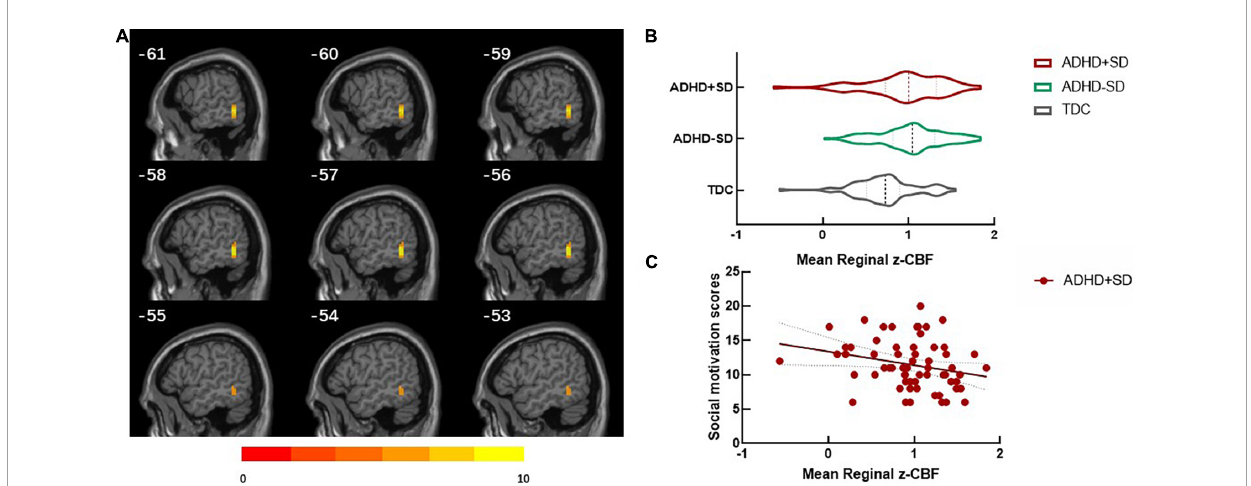
FIGURE1 ADHD-related regional cerebral blood flow in the categorical analysis. (A) Differences in regional cerebral blood flow (rCBF) between ADHD with social deficit subjects (ADHD + SD), ADHD without social deficit subjects (ADHD-SD), and typically developing controls (TDC). (B) The mean rCBF in the left middle/inferior temporal (cluster = 32, and peak MNI = –57, 51, 6) in the three groups. (C) The negative correlation between the mean rCBF in the left middle/inferior temporal gyrus and social motivation scores ( r = —0.275, P = 0.034) in the ADHD + SD subjects.